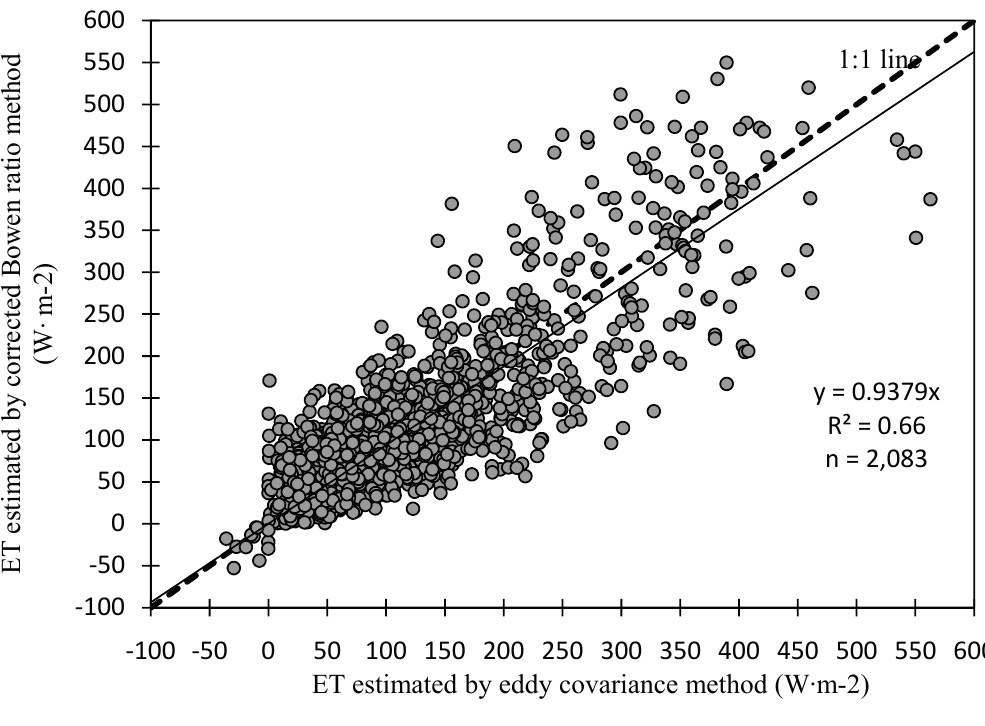
Figure 9. Comparisons between corrected hourly Bowen ratio ET estimation against eddy covariance hourly ET data for the growing and non-growing (dormant) seasons in 2005 and 2006.